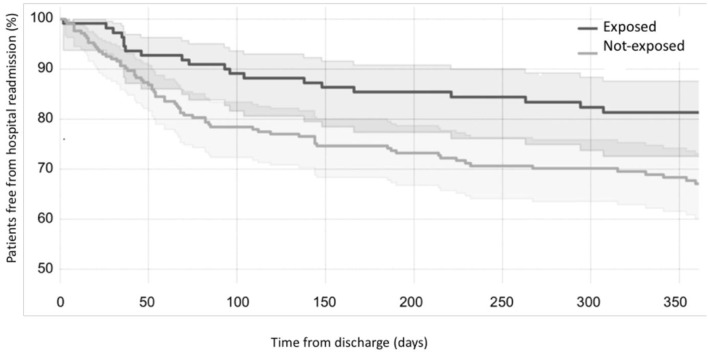
Effects of CORE protocol on hospital readmission. Kaplan-Meier curves showing the proportion of individuals free from hospital readmission over time (black curve = exposed to CORE group; gray curve = not-exposed to CORE group).